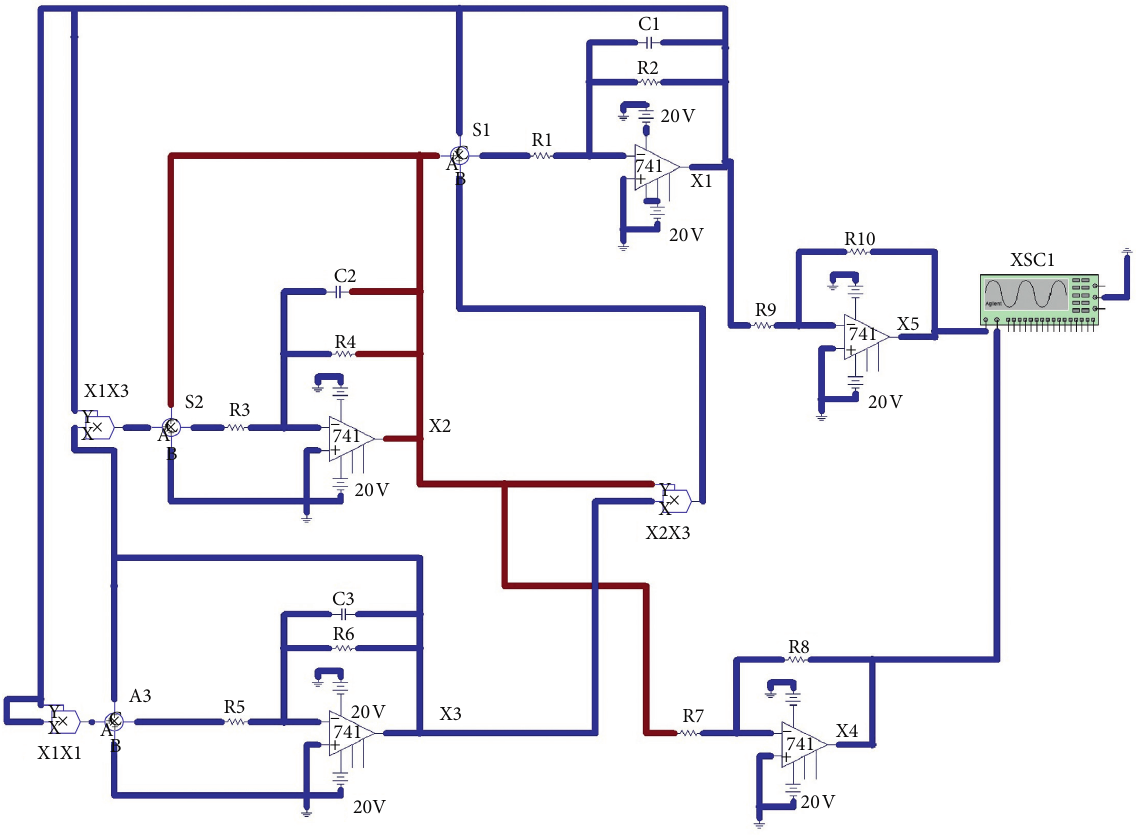
Figure 5: The electronic circuit of the proposed